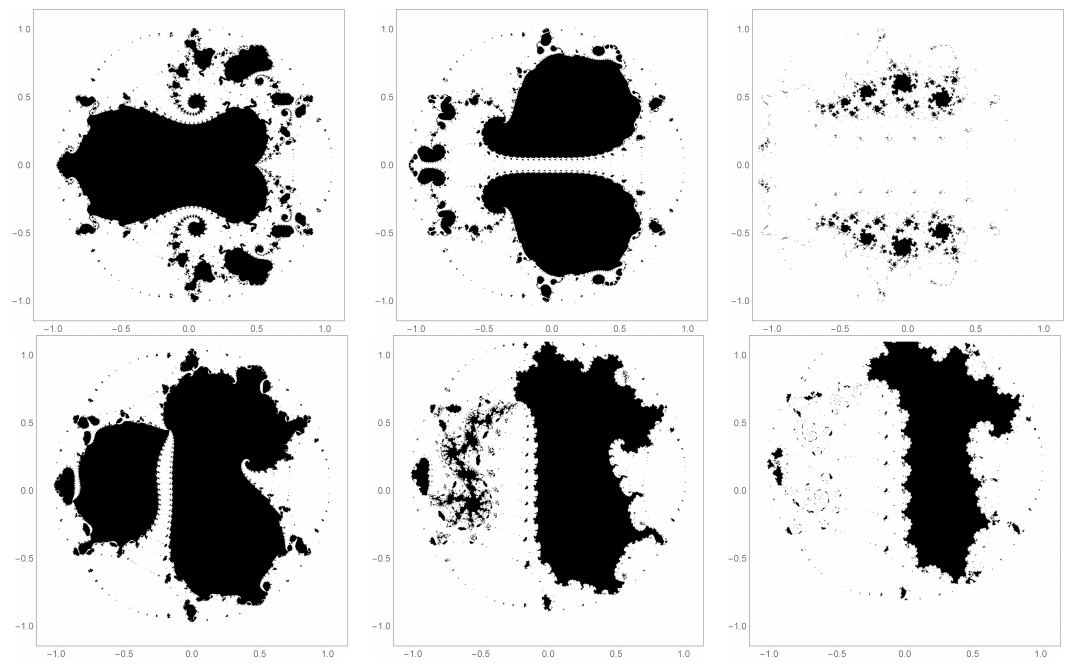
Figure 8. Filled-in Julia sets of k = 3 after an offset parameter has been applied to them. An offset of c = − 0.04, 0.04 and 0.20 (top left, center and right respectively) is applied the base filled-in Julia set along the real abscissa. The bottom row shows an offset of c = − 0.04 i , − 0.12 i , − 0.20 i (left, center and right respectively) along the imaginary ordinate. These offset, filled-in Julia sets make up the corresponding Mandelbrot set. The graphs above were constructed using N = 8 and j = 32 with a resolution of 1.5 million